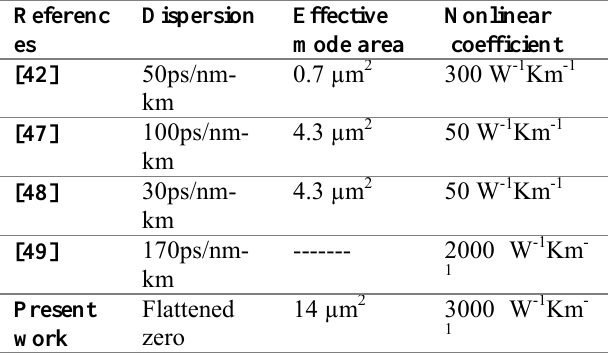
Table II: Comparison with the previously reported PCF structures at 1.33µm